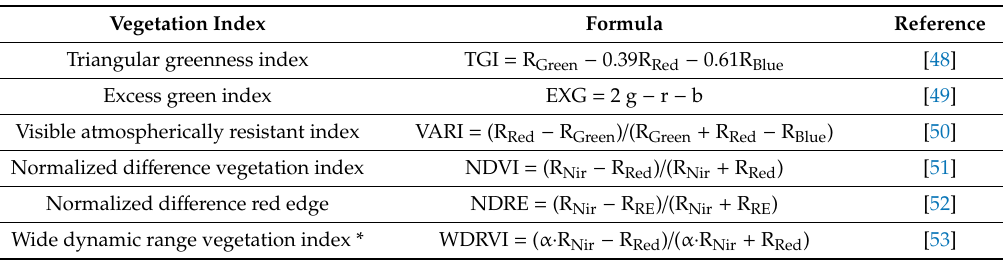
Table 2. Vegetation indices estimated from multispectral and visible images. R Nir , R red , R RE , R Green , R Red , and R Blue are the reflectance values for the near infrared, red, red edge, green, red, and blue bands,